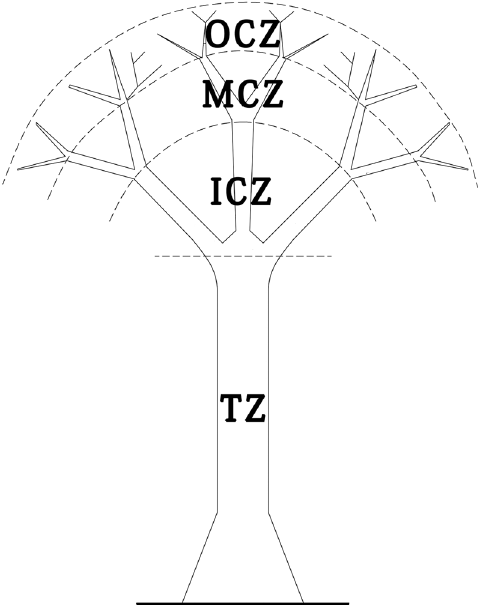
Fig 1. Diagram of the vertical zones of host trees where epiphyte is distributed. TZ, ICZ, MCZ and OCZ indicated trunk zones, inner crown zones, middle crown zones and outer crown zones of host trees, respectively. This disgram is redrawn from Johansson